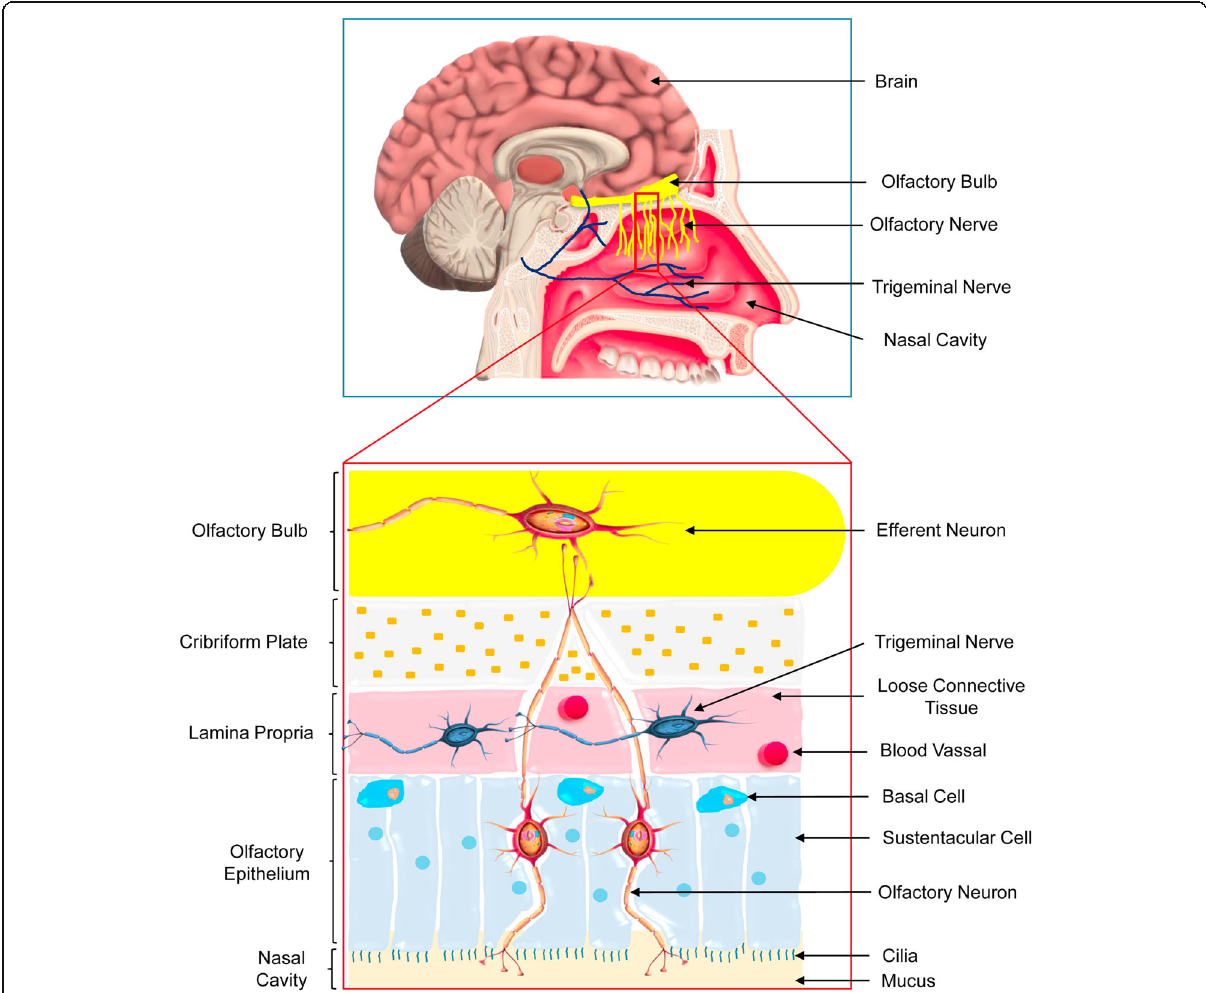
Fig. 2 Anatomy of human nasal cavity. The nasal cavity is divided into the vestibule, respiratory and olfactory sections. The nasal vestibule is the dilated area at the nostril opening. The respiratory section of the nasal cavity refers to the passages through which air travels into the respiratory system. The high level of vascularization and the presence of microvilli make the respiratory epithelium as the primary site for systemic drug absorption. The olfactory region of human nasal cavity (2-12.5 cm2) represents only 1.25 - 10% with a thickness of 60 μ m. The olfactory epithelium provides an option for the entry of drug/ formulation directly into the